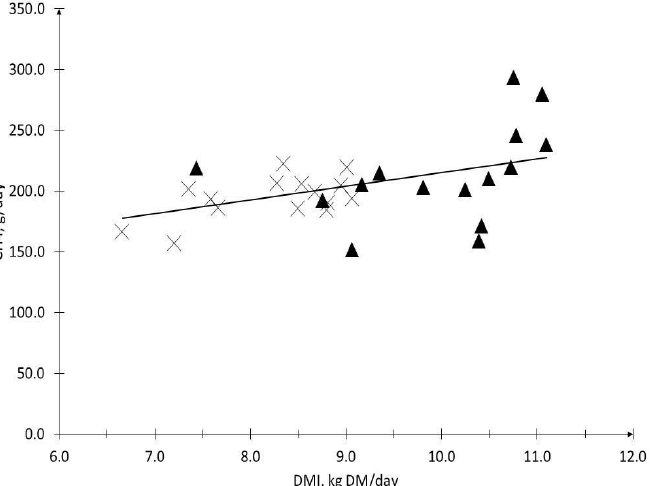
Figure 1. The relationship between dry matter intake (DMI) and CH 4 production of steers fed moderate-fiber (MF, black triangle) and high-fiber (HF, cross) diets. r 2 = 0.51, p = 0.0043, and Y = 12.79x + 87.53.